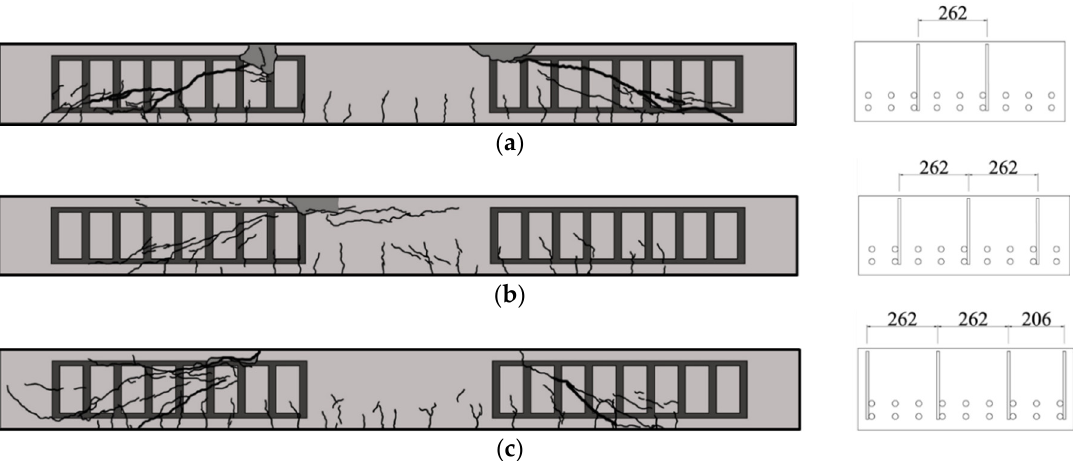
Figure 6. Crack pattern for various number of shear reinforcement legs: ( a ) 1S-NL2; ( b ) 1S-NL3; ( c )